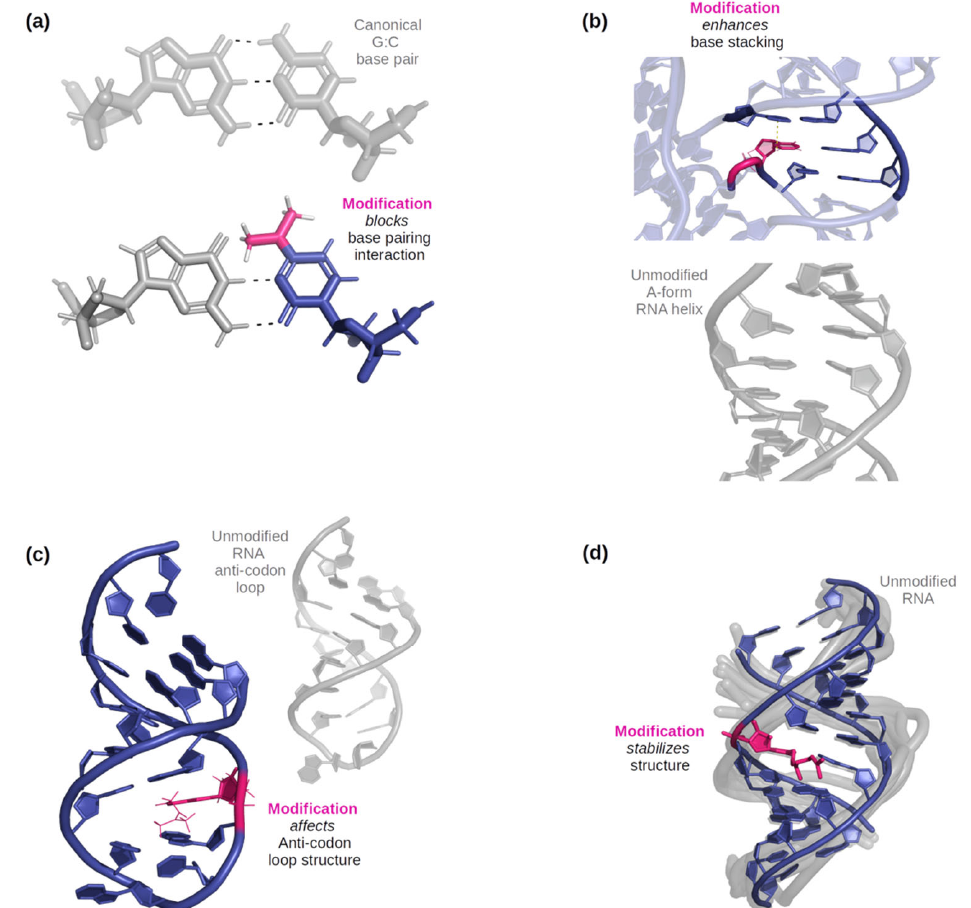
Figure 1. ( a ) An example of how a modification can affect base-pairing interactions. Here, N 4 , N 4 -dimethylcytidine (in pink) has only two possible base-pairing sites on its W-C-F edge due to the double substitution of methyl groups on the amine, while a typical G: C base pair would have three [36]. ( b ) An example of three base pairs, one only with canonical bases, and the other with one RNA modification (5-methylcytidine, illustrated in pink). The dashed line indicates where the methyl group would help stabilize stacking with the nucleobase above it [37]. ( c ) An example of a modified anticodon loop structure vs an unmodified anticodon loop. Due to N 6 -isopentenyladenosine (in pink), an additional base pairing occurs below the modification and the nucleotides in the loop become more stable as it became smaller [38]. ( d ) An example of an effect on helical stability due to the presence of 2-geranylthiouridine (shown in pink) [39].